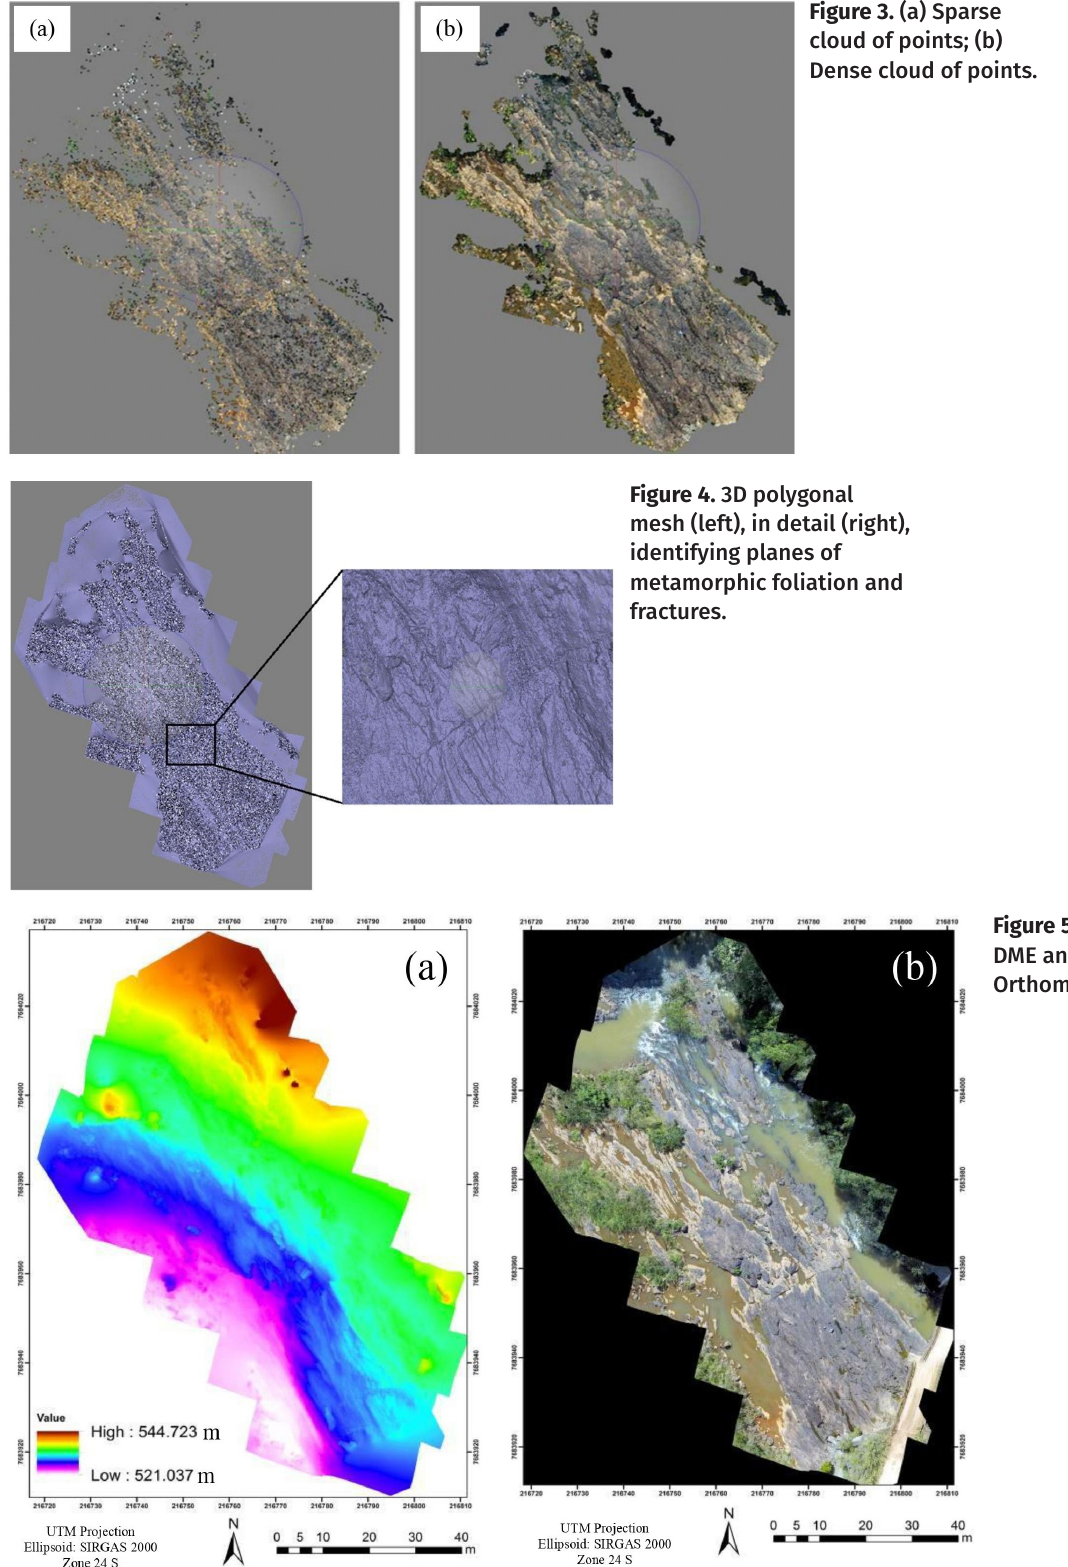
Figure 3. (a) Sparse cloud of points; (b) Dense cloud of points.